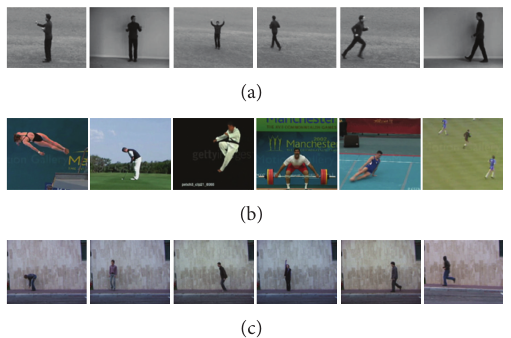
Figure 4: Examples from the public datasets: (a) KTH dataset; (b) UCF sports dataset; (c) the Weizmann